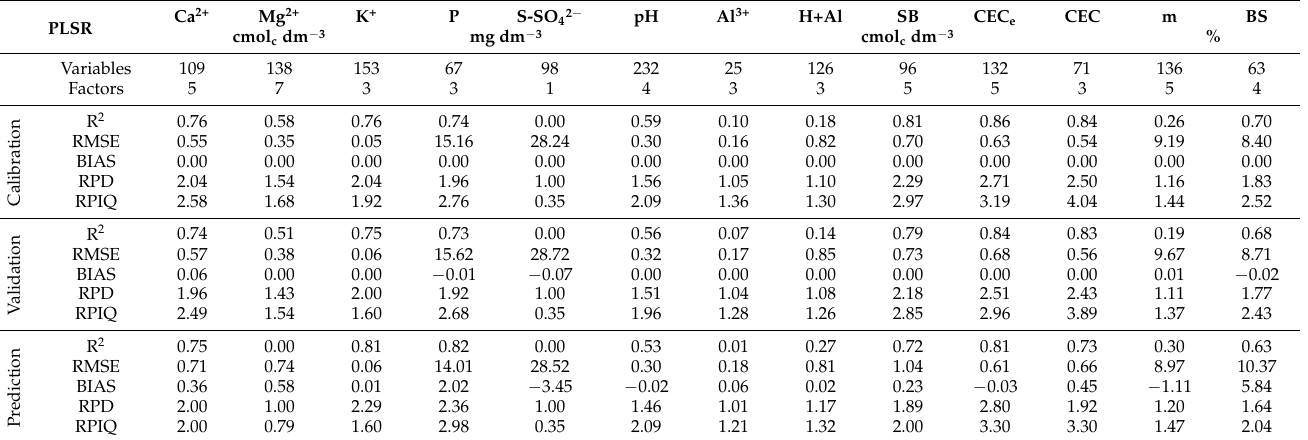
Table 3. Statistical parameters of PLSR models developed from the first soil assessment (with iPLS selection).